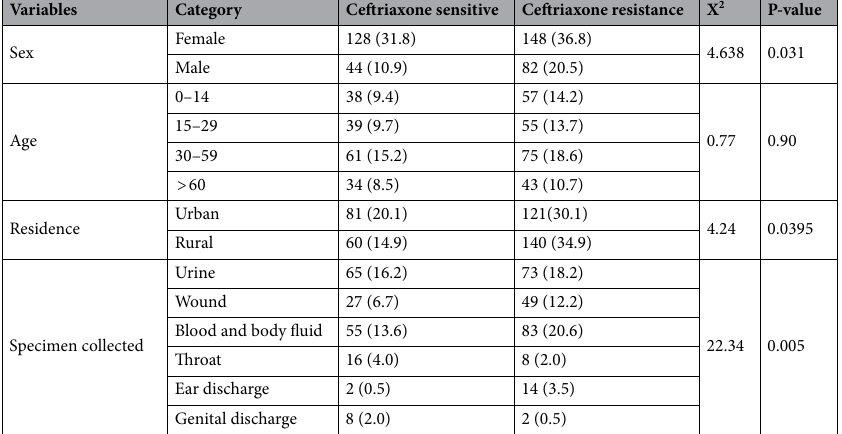
Table 4. Association of resistance with some sociodemographic characteristics.